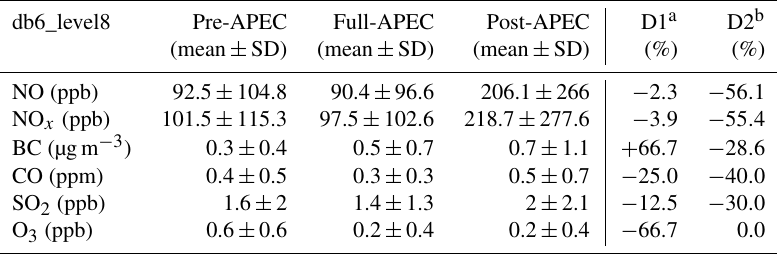
Table 5. The mean on-road emission concentrations (i.e. C veh . ) obtained from the WTM and their relative changes between the pre-APEC, full-APEC, and post-APEC periods.